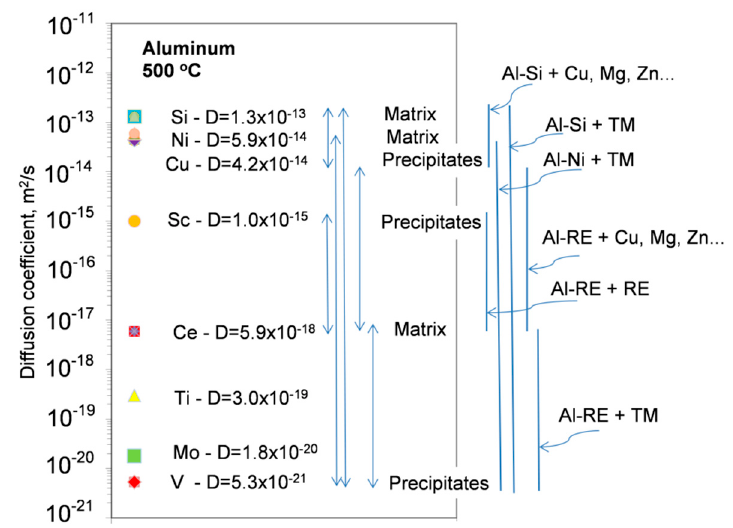
Figure 21. A development strategy of cast Al alloys with high temperature stability through combining of appropriate matrix (Al − Si, Al − Ni, Al − RE) and strengthening compounds (conventional elements, RE, TM). Strengthening can be e ff ective after casting or / and after post-casting heat treatment. Di ff usion coe ffi cients of alloying elements in aluminum at 500 ◦ C were calculated based on data in Tables A1–A3 in Appendix A. RE—rare earths; TM—transition